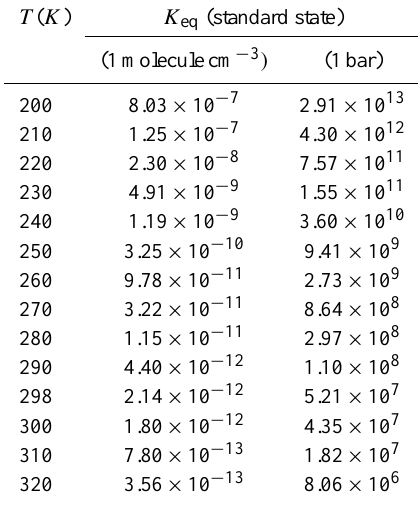
Table 5. Recommended equilibrium constant, K eq ( T ), for Br+Hg → BrHg as a function of temperature for two standard